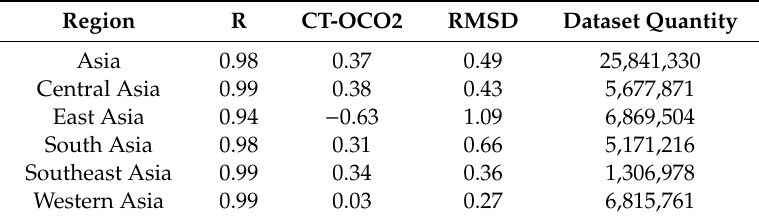
regions. The monthly averaged statistics are computed for 5 years starting from September 2014 to